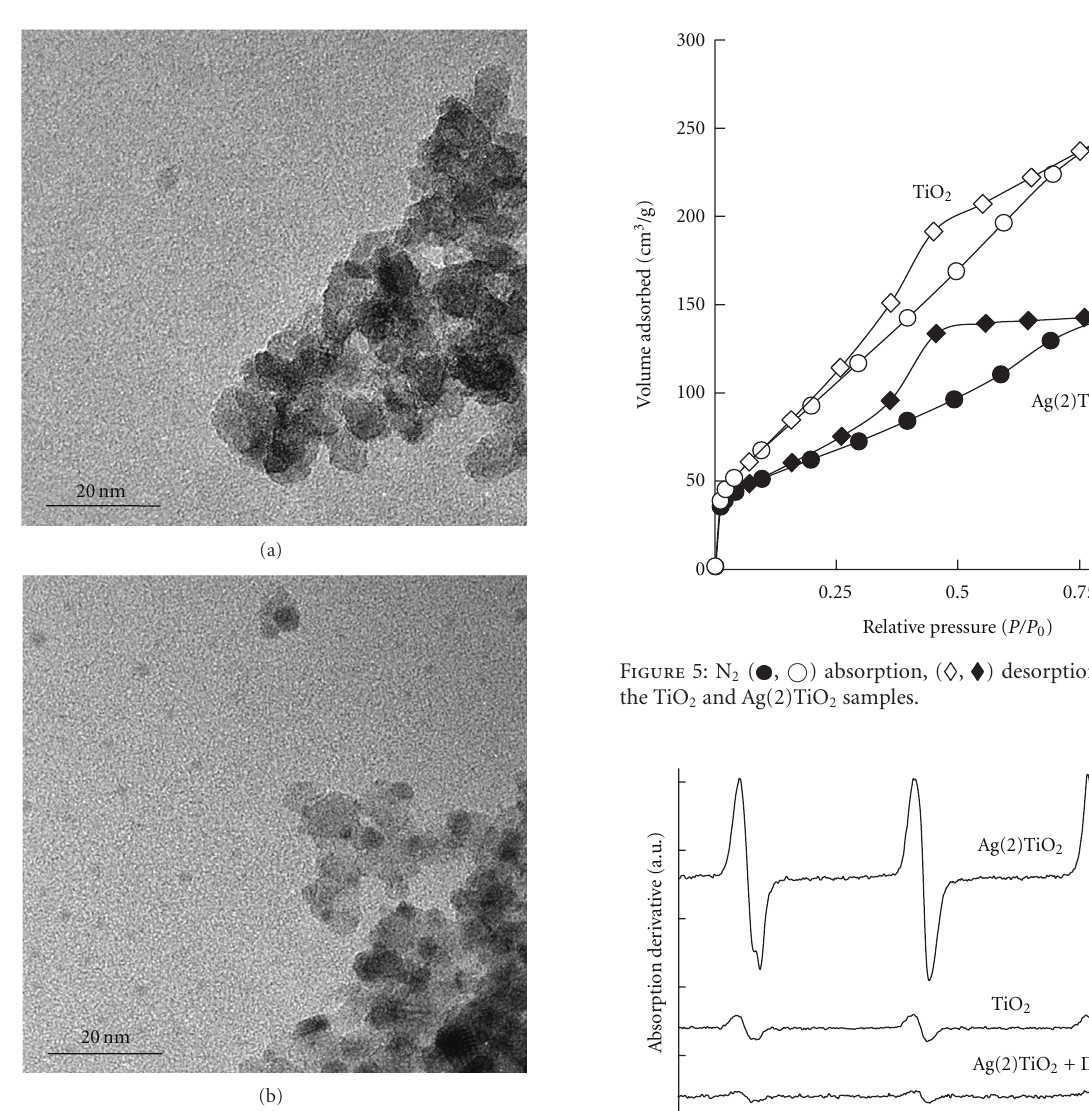
Figure 4: TEM micrographs of the (a) TiO 2 and (b) Ag(4)TiO 2 samples. Index (b) is missed in the current phrase.